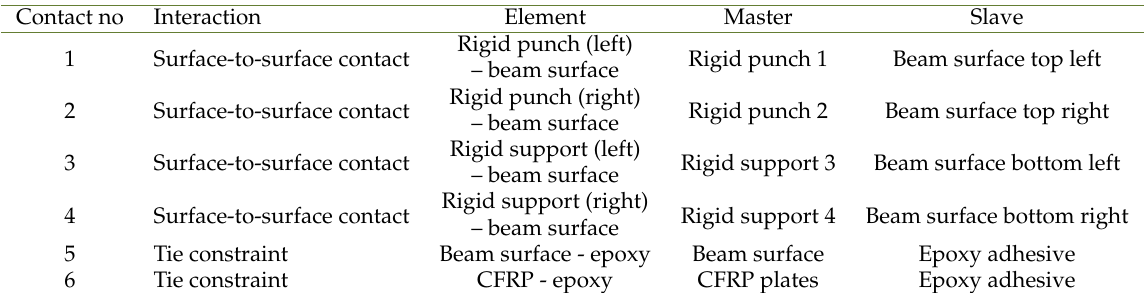
Table 1. Surface Interactions involved within the current modelling framework. Contact